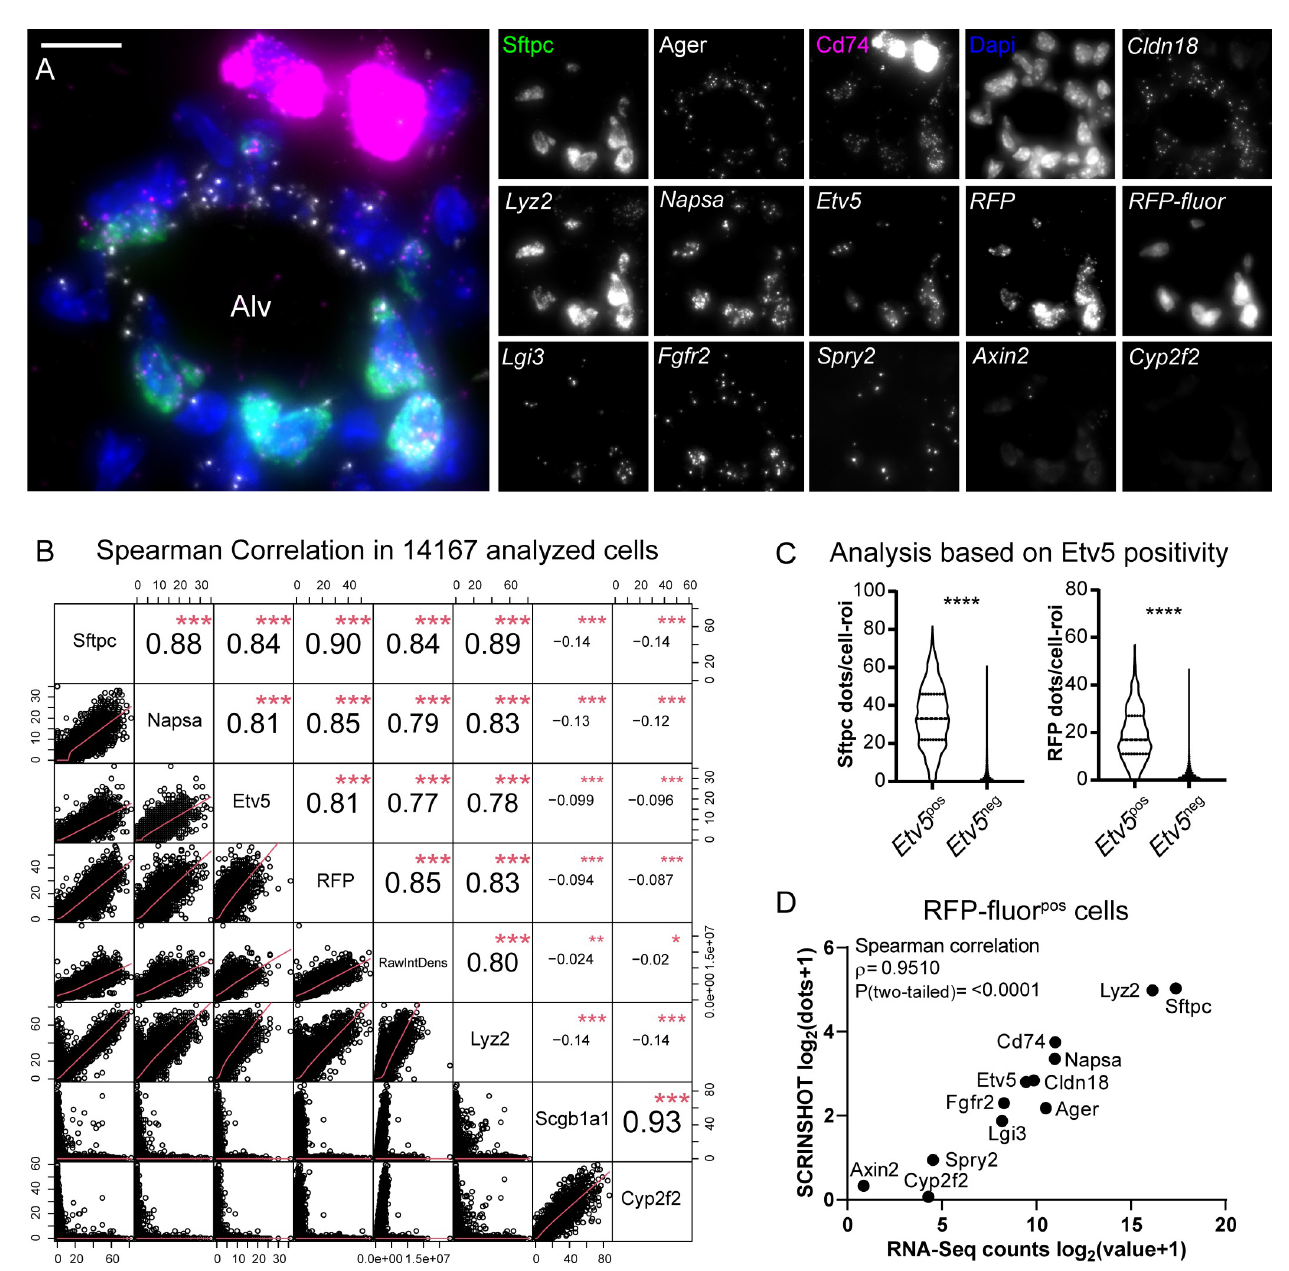
Fig 5. SCRINSHOT multiplex detection for AT2 selective genes indicates quantitative performance and high correlation with the GSE118891 scRNA-Seq dataset [36]. (A) Representative image of an Alv region, showing the SCRINSHOT dots of 13 genes in addition to RFP transgene, RFP protein fluorescence, and the club cell marker Cyp2f2 (negative control). Merge image includes Sftpc (green), Cd74 (magenta), Ager (gray), and DAPI (blue). The rest are indicated with italics, and only single-channel images are shown. Scale bar: 10 μ m. The data underlying this Figure section can be found in 10.5281/zenodo.3634561. (B) Spearman correlation analysis, in all analyzed cells (14,167) of the Sftpc-CreER pos ; Rosa-Ai14 pos lung section, for the highly selective AT2 markers, Sftpc , Napsa , Etv5 , and Lyz2 . RFP SCRINSHOT-detected RNA transcripts and RFP protein fluorescence (raw integrated density) were also included to the correlation, as AT2 markers. Scgb1a1 and Cyp2f2 club cell markers were used as negative controls, anticorrelating with all other markers (negative coefficient values, ρ ). (C) Violin plots of Sftpc (left) and RFP (right) SCRINSHOT dots, in Etv5 pos ( > 3 dots) and Etv5 neg (0–3 dots) alveolar cells. Etv5 pos n = 1,431 cells and Etv5 neg n = 12,736 cells. (D) Correlation plot of the indicated genes, between the average log 2 (raw counts+1) values of 156 AT2 cells of GSE118891 and SCRINSHOT signal dots of 1,425 RFP fluorescence positive cells. The data underlying these Figure sections can be found in 10.5281/zenodo.3978632. Alv, alveolar; AT2, alveolar type 2; RawIntDens, raw integrated density; RFP, red fluorescent protein.